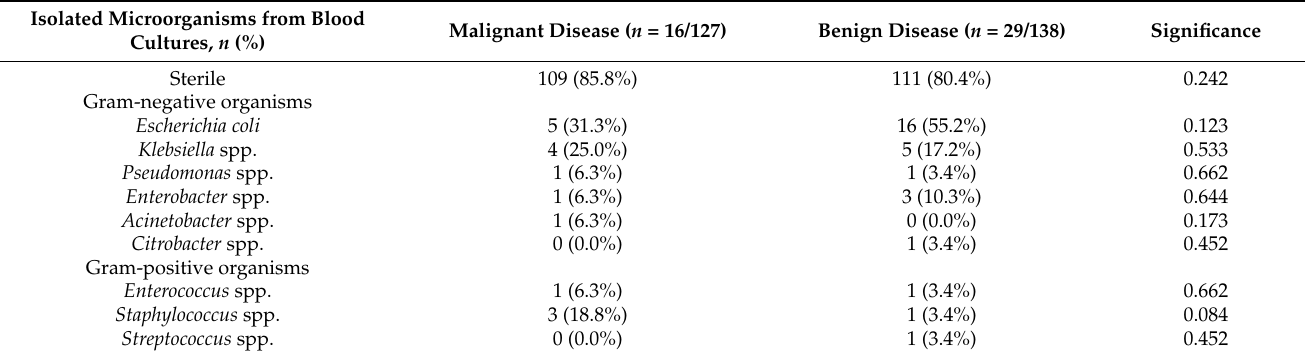
Table 5. Comparison of isolated microorganisms from blood cultures between patients with malignant and benign causes of obstruction.